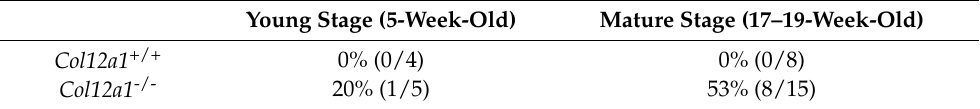
Figure 2. ACL discontinuity in Col12a1 deficient mice. Hematoxylin/eosin and safranin O/fast green staining of sagittal sections of the knee joints from 19-week-old wild-type and Col12a1 -/- mice. In wild-type mice, ACLs and PCLs were found in the knee joints where they ran diagonally and connected the femur and tibia ( a , black arrows). In contrast, in Col12a1 -/- mouse knee joints, ACLs were discontinuous ( b , open arrows). The Col12a1 -/- PCLs were intact, and no differences were observed between genotypes ( b , black arrows). Bars = 500 µ m. Table 1. Incidence of ACL discontinuity in young and mature Col12a1 -/- and Col12a1 +/+ control